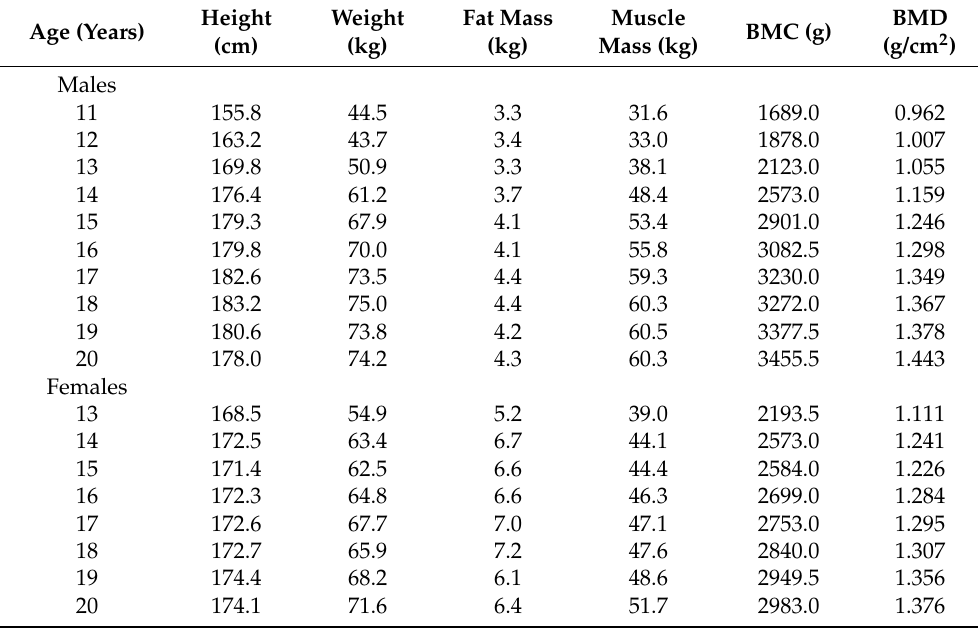
Table 2. Medians for body size, fat and muscle mass, BMC, and BMD in the young male and female athletes by age